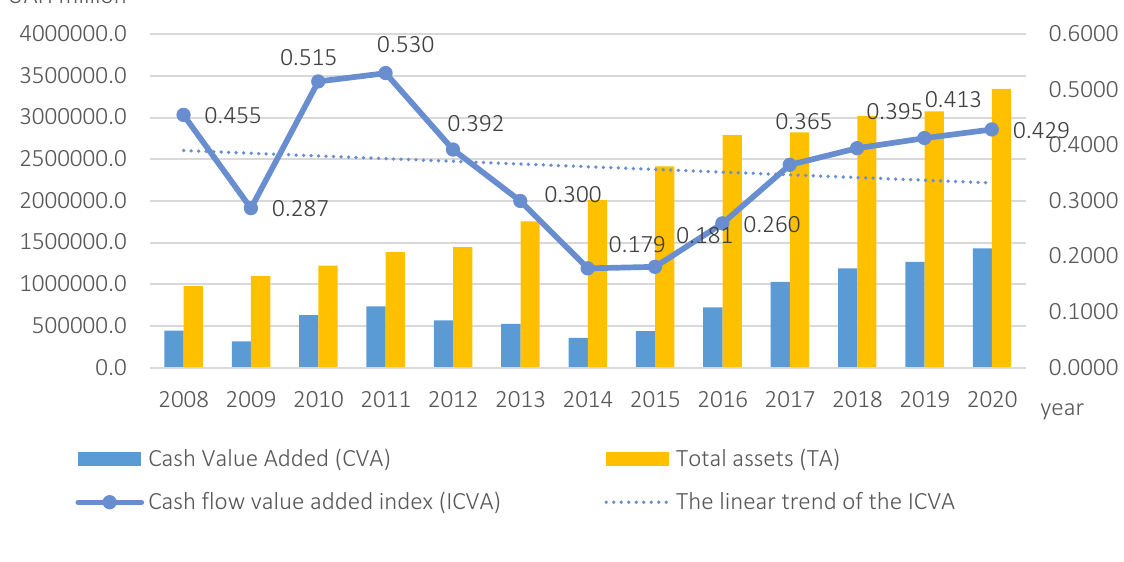
Figure 1. Dynamics of the СVA indicator according to the consolidated balance sheet of Ukrainian